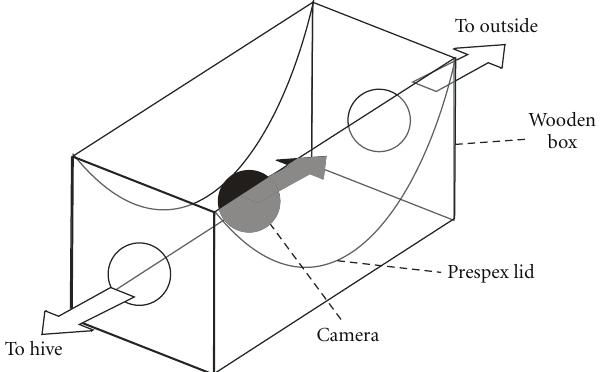
Figure 1: The camera box that bees must pass though to leave the hive. Bees are forced in the lower half of the box, under the curved perspex lid. This design forces all bees entering and exiting the hive to show their backs (and hence any numbered disc) to the camera positioned on top of the perspex